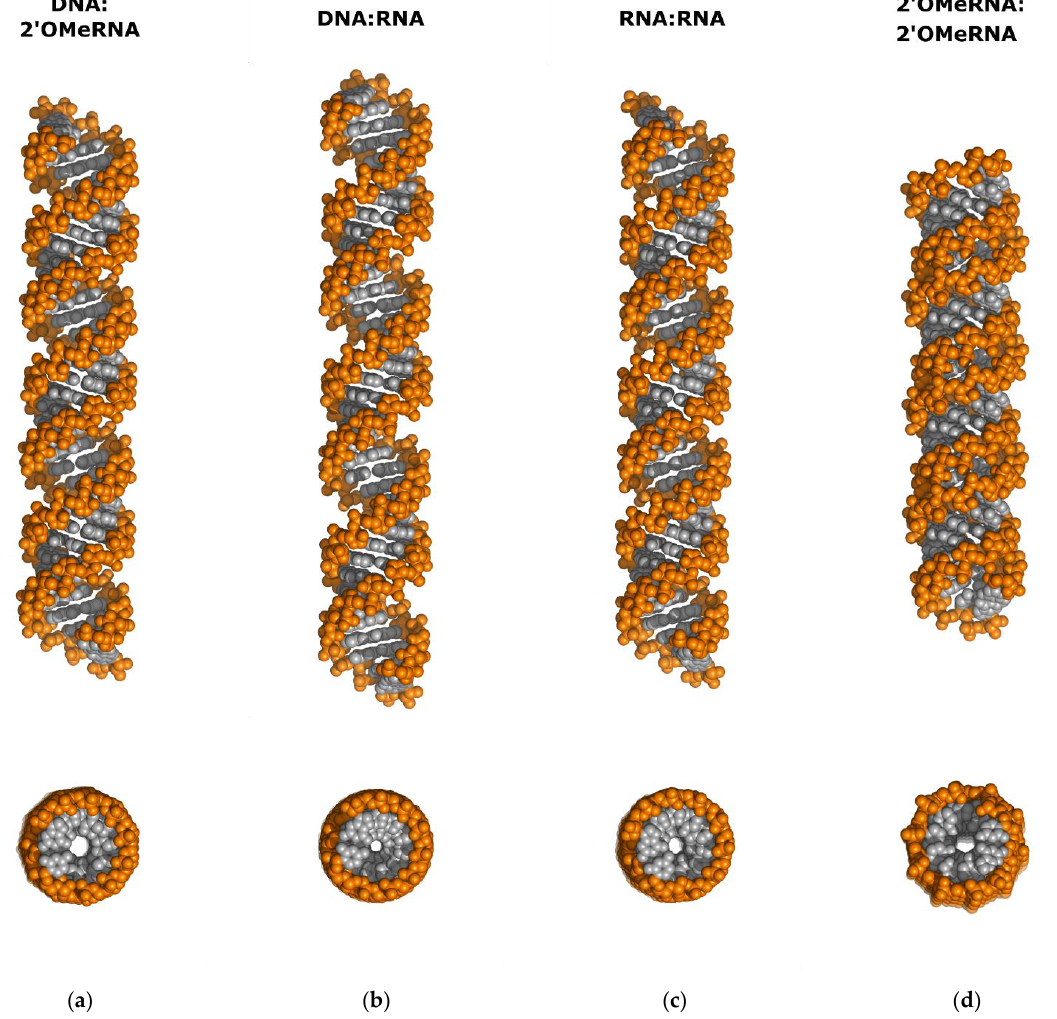
Figure 7. Comparison of idealized duplexes of ( a ) DNA: 2′ -OMe-RNA (derived from 7ow0.pdb), ( b ) DNA:RNA (derived from 479d.pdb), ( c ) RNA:RNA (derived from 1sdr.pdb), and ( d ) 2′ -OMe- RNA: 2′ -OMe-RNA (derived from 1i7j.pdb). All helices were expanded to 40 bp per duplex and represented as space-filling models. Side view (top) and top view (bottom). Base pairs are shown in gray, while phosphates and sugar units are colored orange. Details are described in the text.